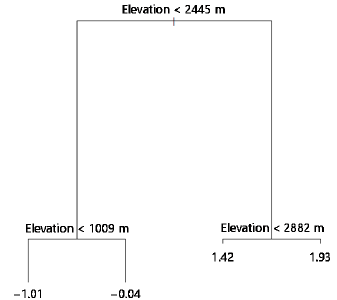
Figure 4. Classification of the study plots by elevation using tree model. The values indicate mean NMDS 1 axis score for each group.